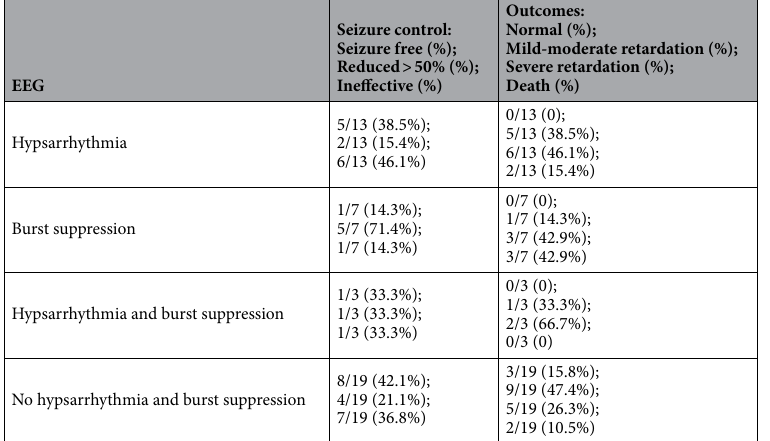
Table 5. The table of EEG and prognosis. EEG,